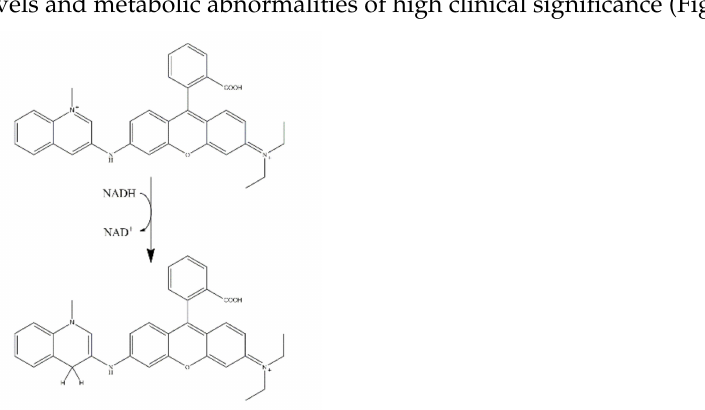
Figure 42. The possible sensing mechanism of MQR (Table 3, No. 3) for NADH [92]. Gu T., et al. reported another reaction type sensor, named RhB-NIR (Table 3, No.4), to detect the H 2 O 2 in living cells [93]. This sensor was triggered by a classical Baeyer- Villiger reaction. Specifically, H 2 O 2 attacked the carbonyl carbon of the amide bond in the sensor structure, causing the rearrangements of α -ketoamide groups (Figure 43). The formed intermediates were successively hydrolyzed, decarboxylated, and released into the